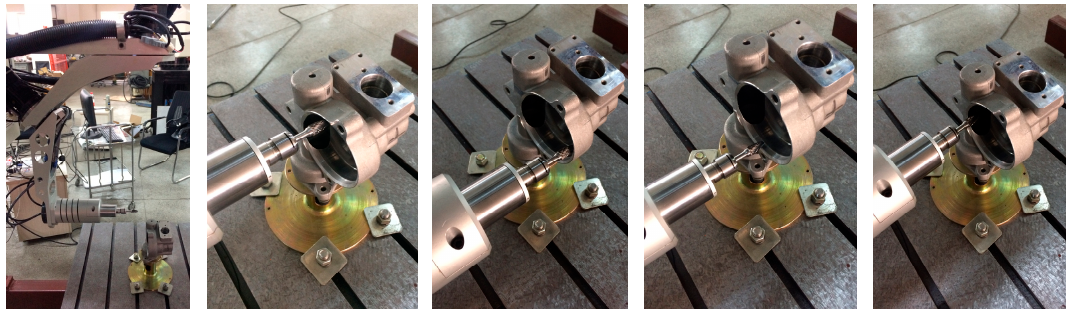
Figure 26. Experimental deburring of orifice edges on proximal side facet.